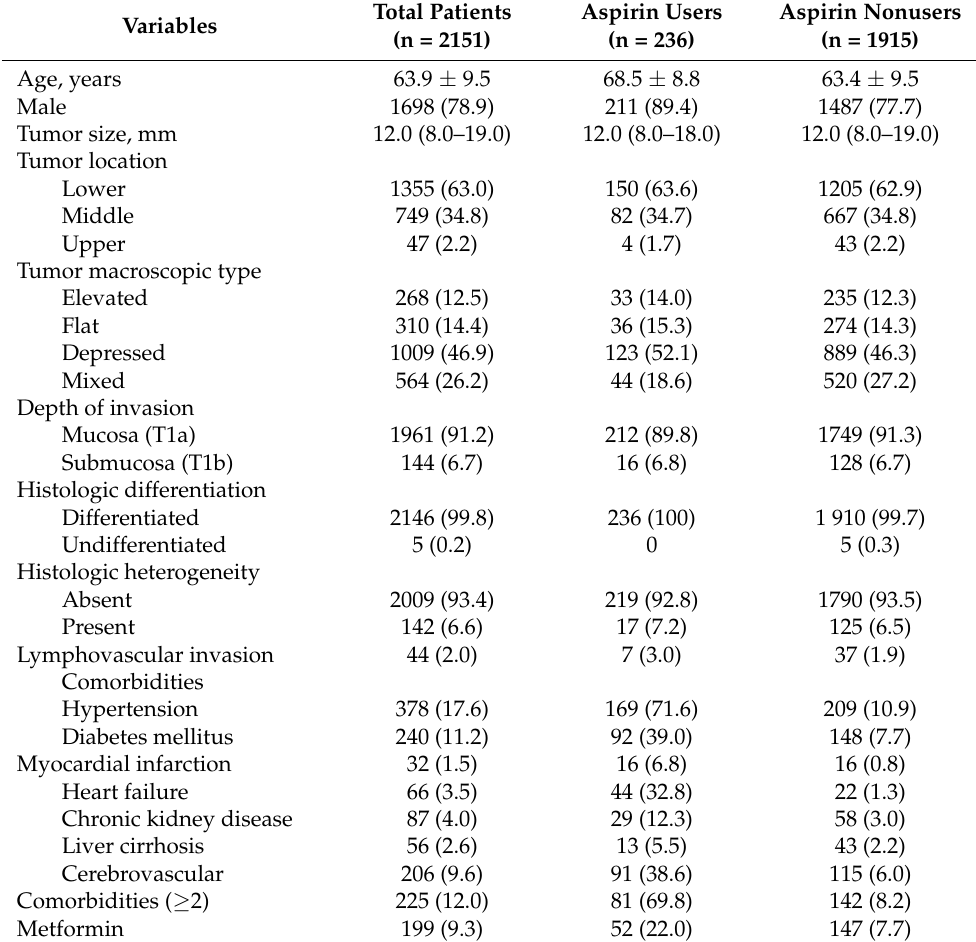
Figure 2. Cumulative incidence of metachronous gastric cancer according to aspirin use. Table 1. Baseline characteristics of the study